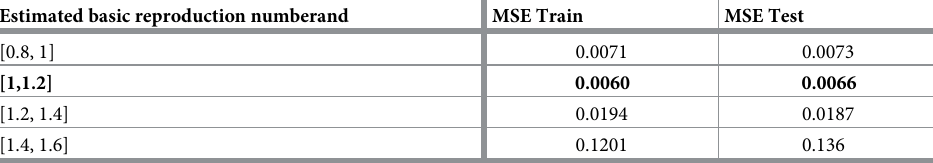
Table 6. Total mean square error (MSE) of training and experimental data in the best implementation of ANN-BTA network for estimating basic reproduction number related to COVID-19 patients in the ranges of